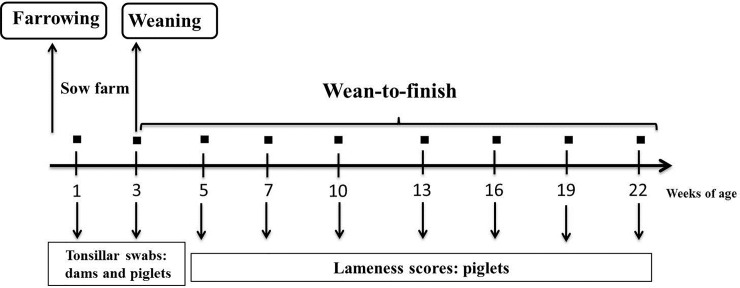
Study experimental design.Dams (n = 29) and piglets (n = 120) were sampled at one and three weeks post-farrowing using tonsillar swabs. Piglets (n = 60) were followed wean-to-finish and lameness was individually scored at 5, 7, 10, 13, 16, 19 and 22 weeks of age.